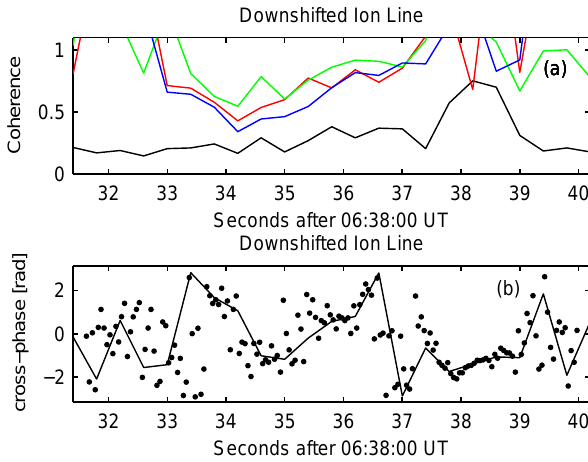
Figure 5. Coherence estimates with noise subtraction and cross- phase history at 400km range with 45km range and 400ms time integration. In panel (a) the coherence estimates are plotted where colors are as in Fig. 1. In panel (b) the cross-phase for the 32m/42m baseline is shown. In addition to the 400ms integrated cross-phase (black solid line) 50ms integrated data are plotted (black